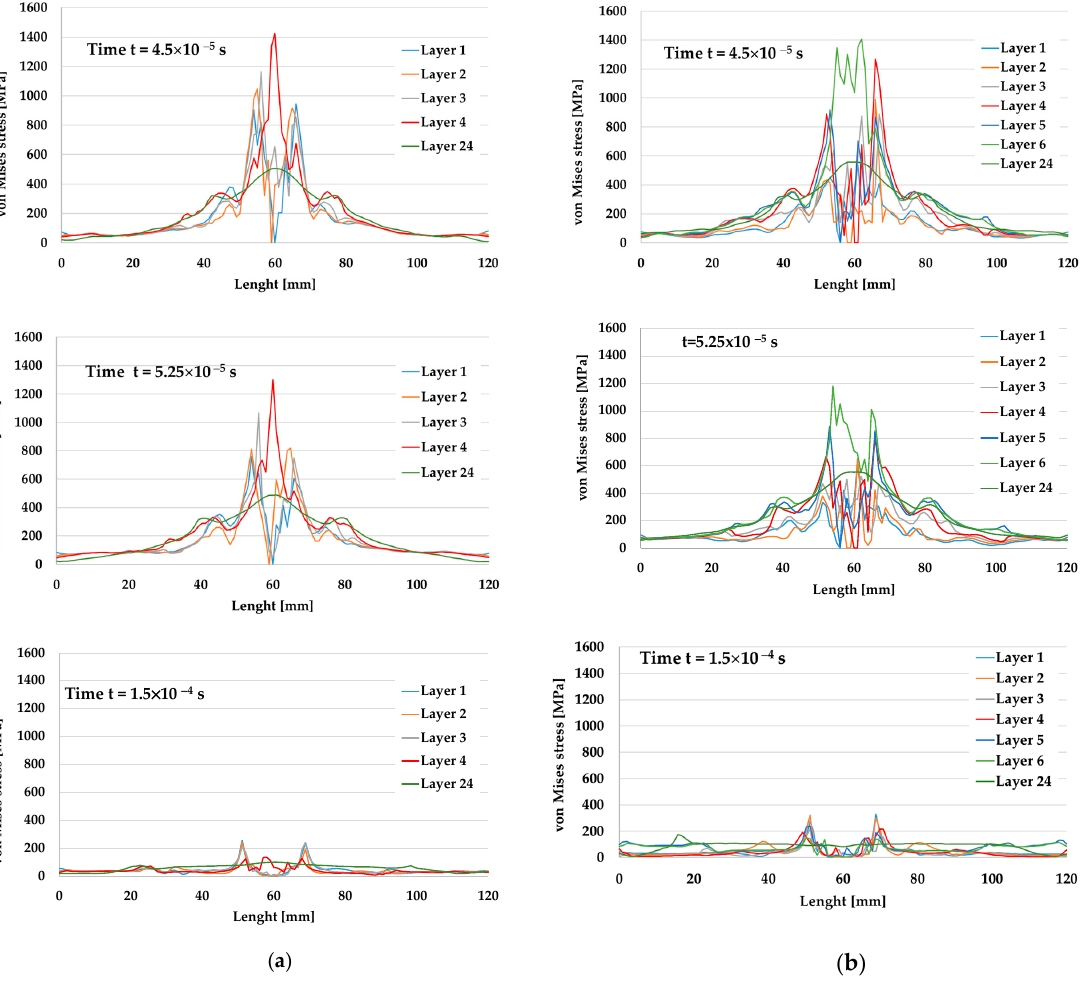
Figure 5. Von Mises stress distributions for broken layers and the last layer (the 24th layer) at different moments of the simulation. ( a ) 9 mm FMJ, v 0 = 375 m/s. ( b ) .357 Magnum, v 0 = 433 m/s.